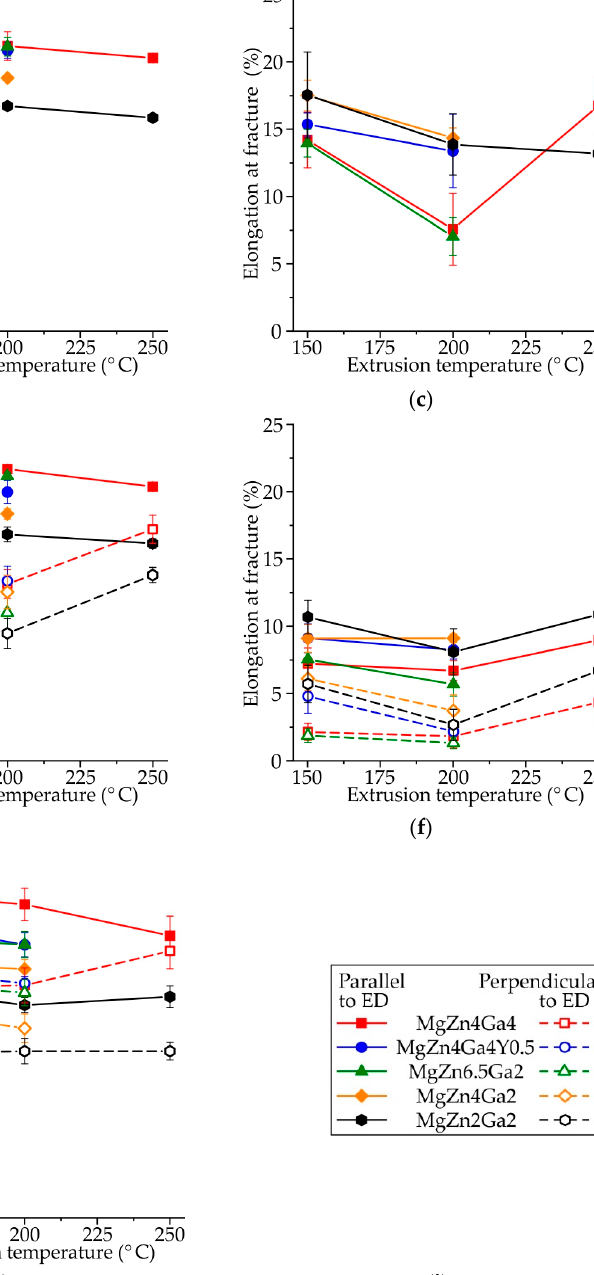
Figure 10. Engineering tensile stress–strain curves for the Mg–Zn–Ga–(Y) alloys extruded at 200 or 150 °C.